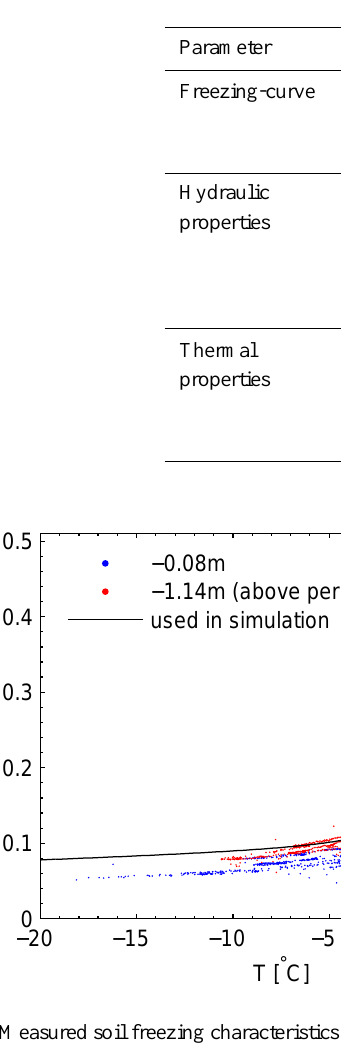
Table 1. Soil parameters used in the simulations. As no convective flow has been modeled for the Tianshuihai site, no Mualem-van Genuchten parameters were necessary.